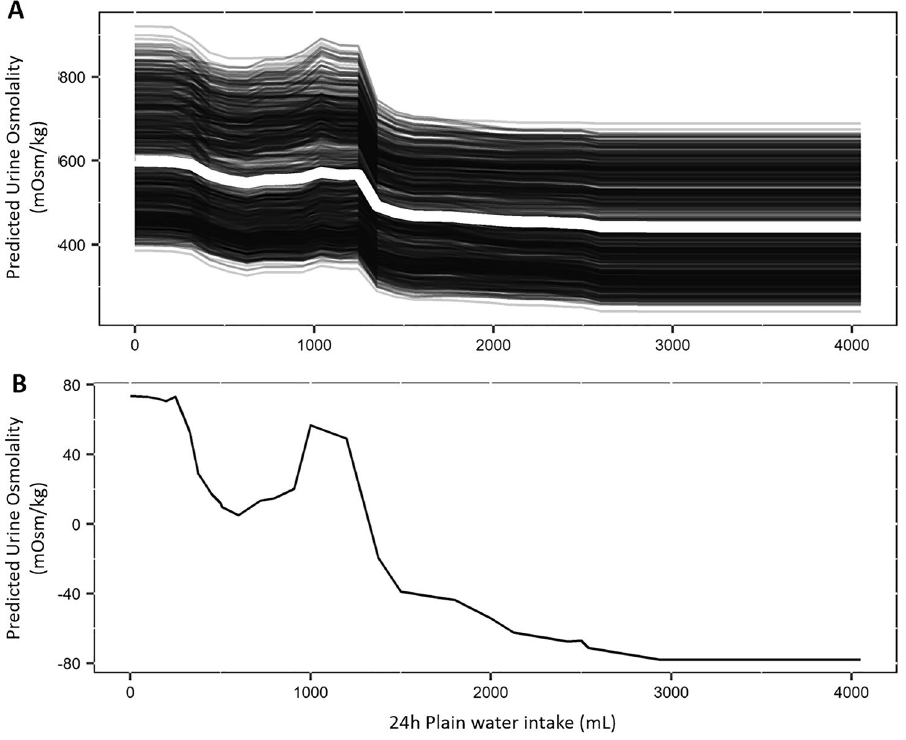
Figure 3. Partial dependence plots ( PDP) and accumulated local effects (ALE) plots for 24 h Plain water intake. ( A ) PDP plot for 24 h plain water intake. The large white curve represents the PDP plot. The black lines represent the individual conditional expectation (ICE) curves, i.e. the equivalent to a PDP for individual data instances. ( B ) ALE plots for 24 h plain water intake. The R pdp package was used to generate the figures https:// journ al.r- proje ct. org/ archi ve/ 2017/ RJ- 2017- 016/ index. html. R Statistical Software version 3.6.3 (R Core Team https:// cran.r- proje ct. org/ bin/ windo ws/ base/ old/3.